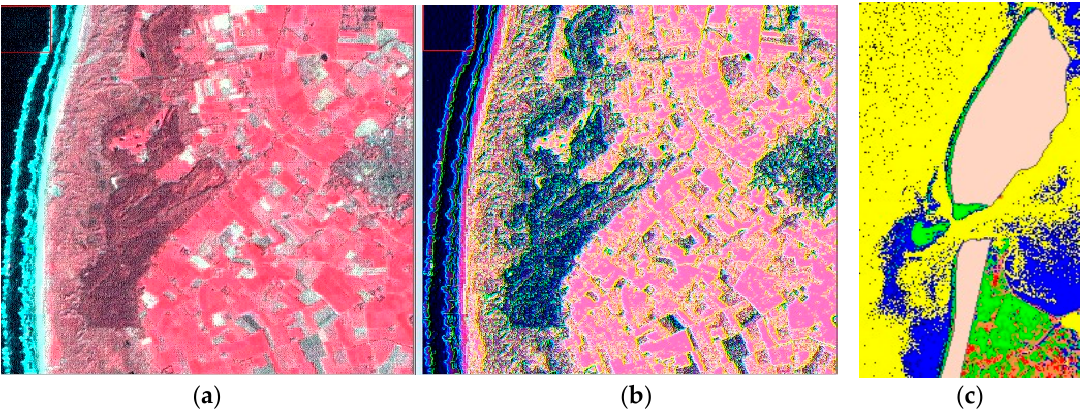
Figure 7. ( a ) Sharpened image; ( b ) ORD edge feature enhanced image; ( c ) Shoreline.